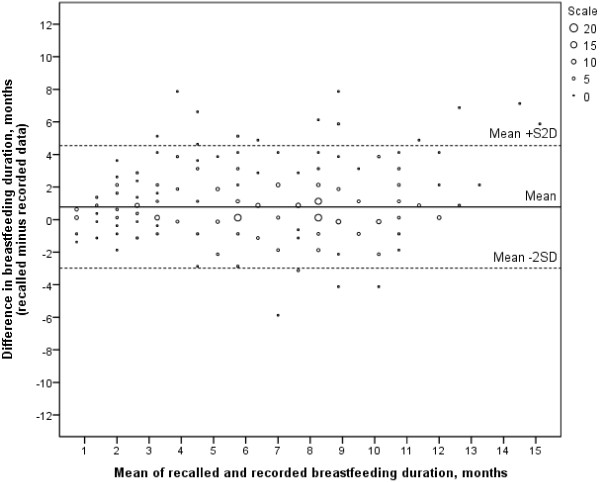
Bland-Altman plot. Differences between recalled and recorded breastfeeding duration vs. the mean of the two breastfeeding durations (n=345). Limits of agreement: Mean ±2 standard deviation (SD), 0.774 ± 2*1.882.